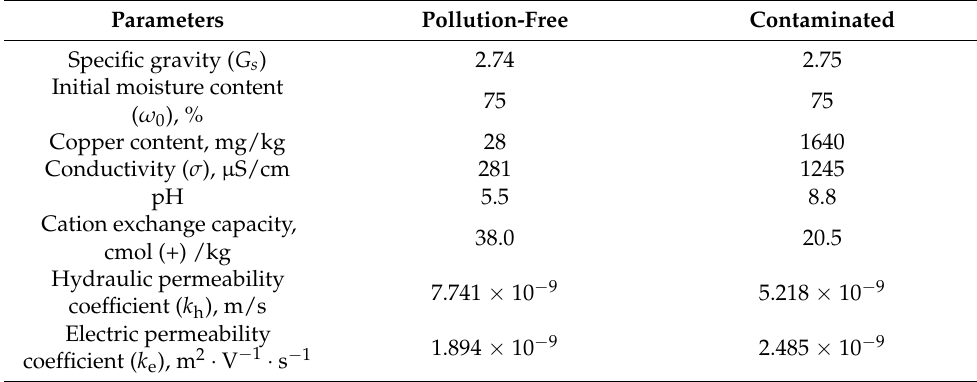
Table 1. Basic physical and chemical characteristics of test